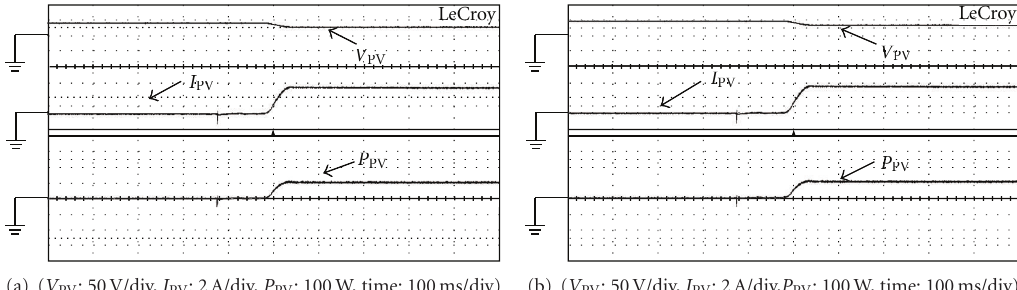
Figure 21: Measured waveforms of voltage V PV , current I PV and Power P VP of PV arrays with perturbation- and-observation method to implement MPPT: (a) P PV(max) = 100W, and (b) P PV(max) =